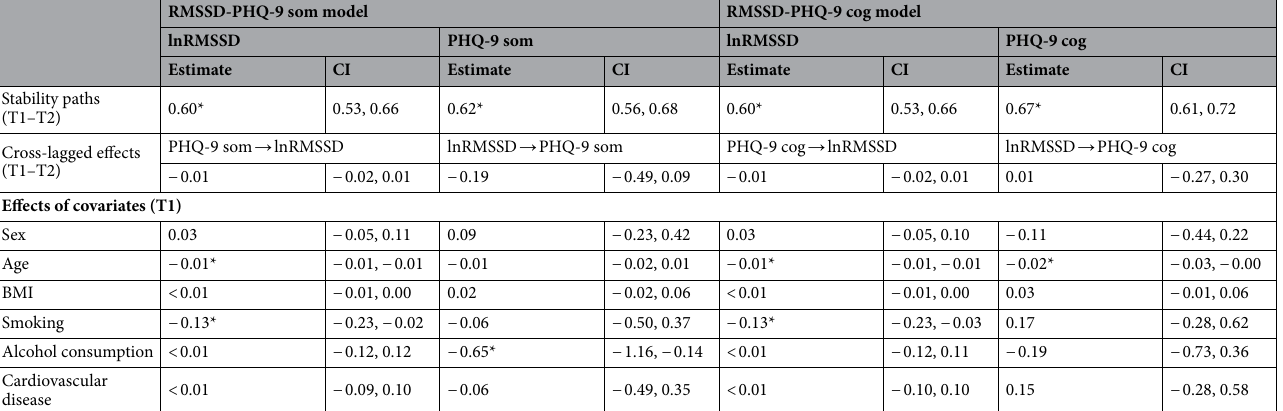
Table 5. Path coefficients of cross-lagged panel models on PHQ-9 factors and lnRMSSD with covariates. Sex is coded 0 = male, 1 = female; BMI = body mass index; Cardiovascular Disease = self-reported hypertension